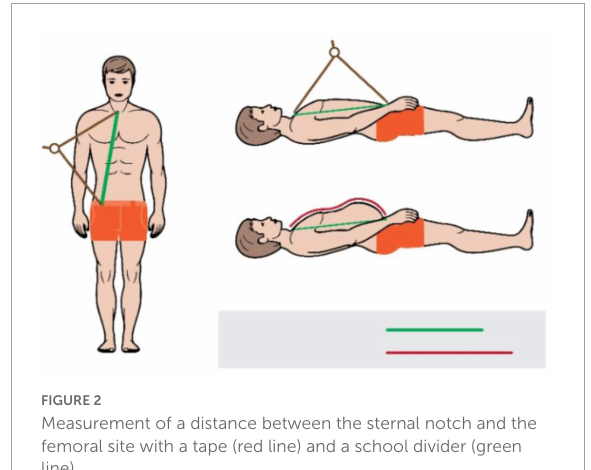
FIGURE2 Measurement of a distance between the sternal notch and the femoral site with a tape (red line) and a school divider (green